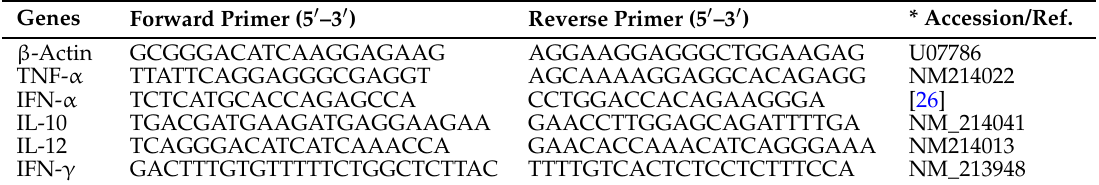
Table 3. Primers used to measure the mRNA expression levels of various